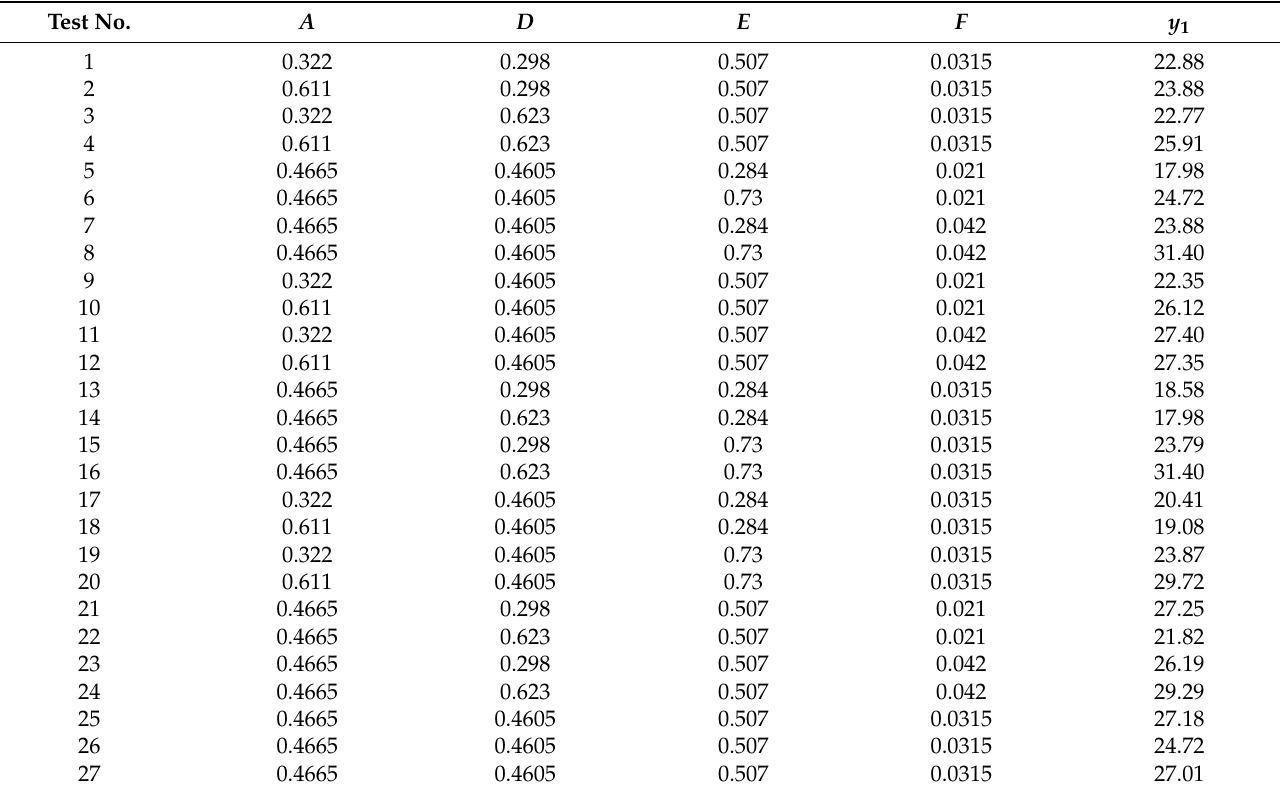
Table 5. Results of rape stems’ contact-parameter-response surface simulation test.